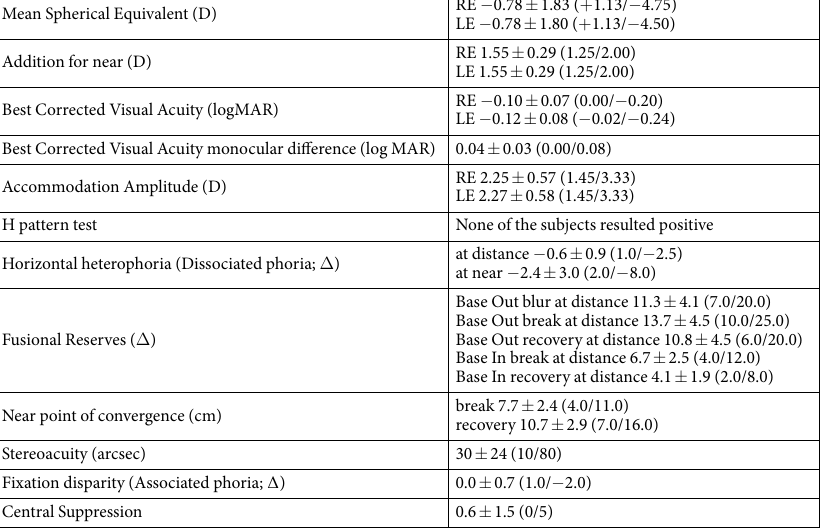
Table 1. Basic visual performance of participants with presbyopia. Mean and standard deviations (with ranges in parentheses) for the preliminary visual assessment variables (RE and LE indicate the right and left eye,